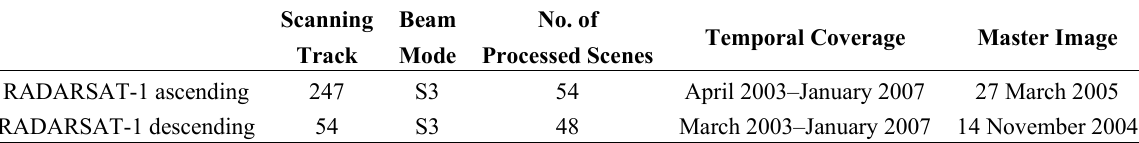
Table 3. The utilized images for Persistent Scatterer Interferometry processing Scanning Beam No. of Temporal Coverage Master Track Mode Processed Scenes